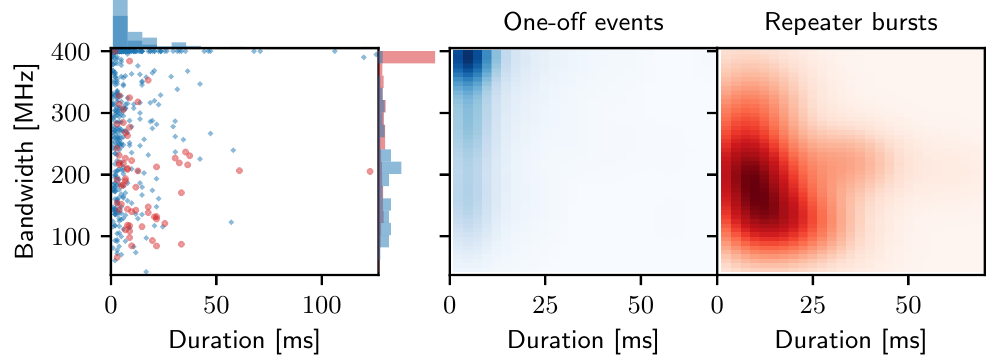
Figure 7. Comparison of the bandwidths and durations of the FRBs in the CHIME Catalog 1. Blue diamonds represent one-off events and red open circles denote repeater pulses. The normalised histograms on the right show that one-off events are narrower in width and occupy a larger band- width compared to repeater bursts, which are broader in width and occupy a comparatively smaller bandwidth. One-off events may potentially be as-of-yet undiscovered repeaters (e.g., due to limited exposure or source activity). Figure credit: Ziggy